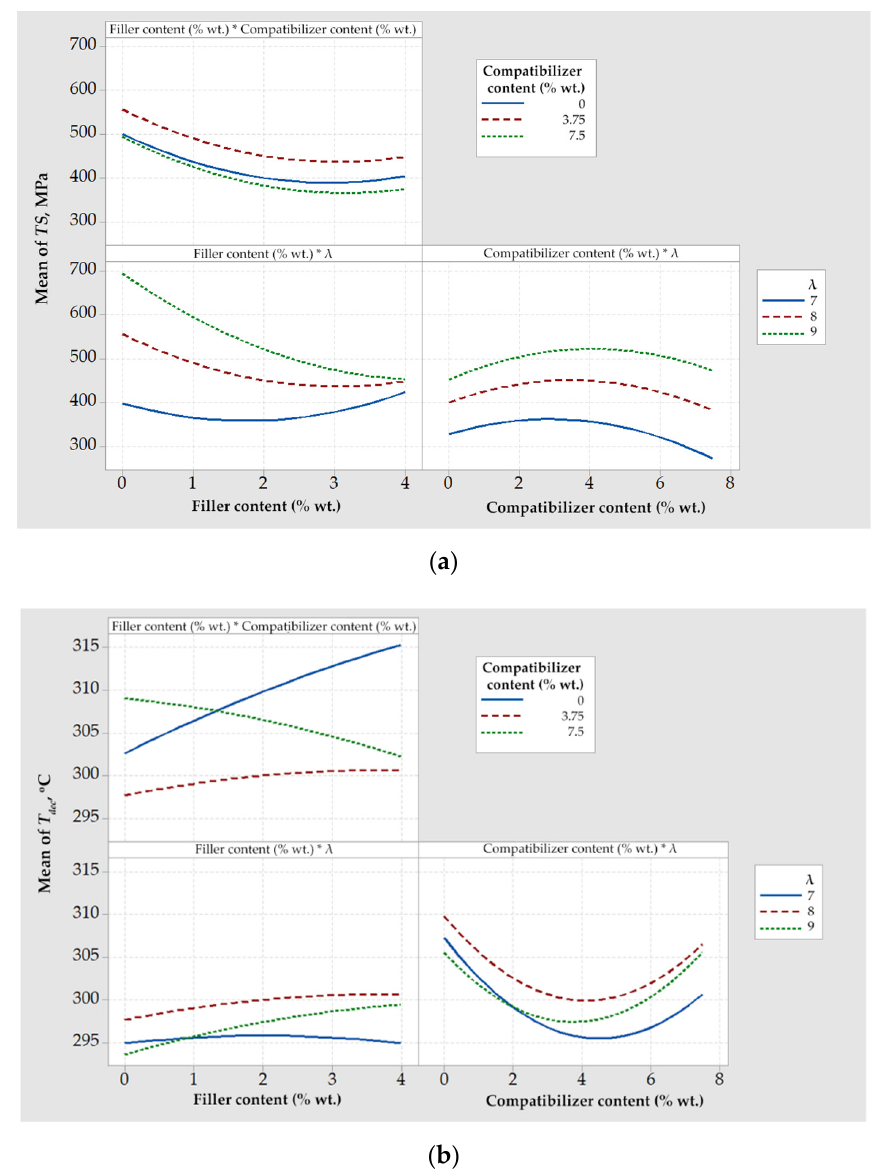
Figure 2. Interaction plots for ( a ) tensile strength, TS , and ( b ) onset decomposition temperature, T dec , regarding composites with talc.